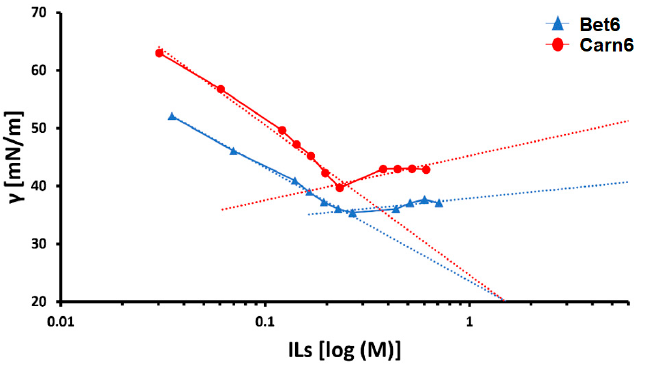
Figure 2. Determination of the critical aggregation concentrations (CACs) of a betaine-based ionic liquid (Bet6) and carnitine-based ionic liquid (Carn6), via surface tension. The CAC values of Bet6 (0.227 ± 0.016 M) and Carn6 (0.226 ± 0.020 M) are not statistically different (n = 3).